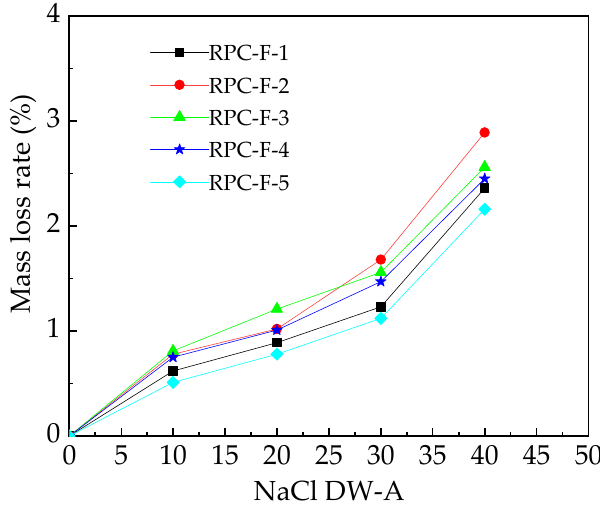
Figure 9. Mass loss rate during NaCl DW-A.